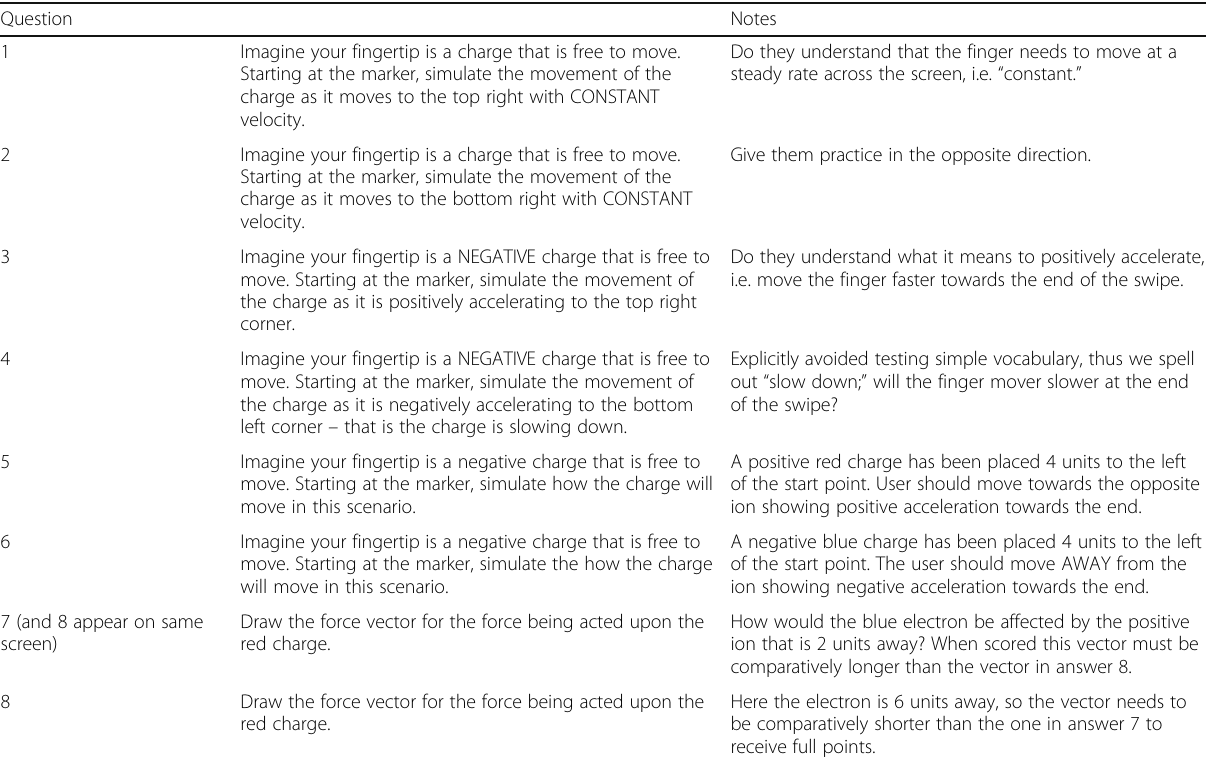
Table 6 Test questions and notes on the testers ’ goals on the Wacom gesture-based test